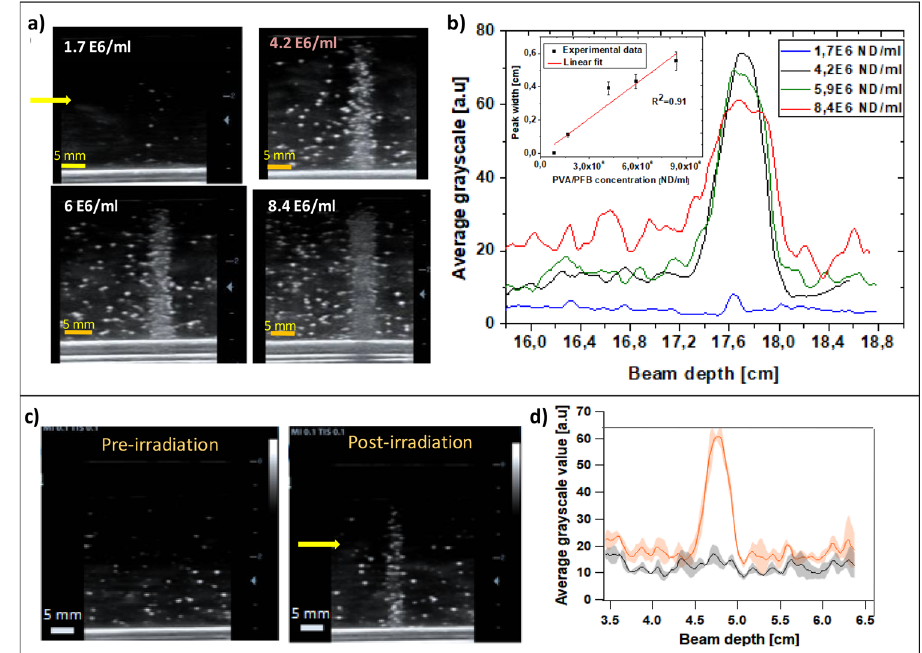
Figure 4. ( a ) US images (@7.5 MHz; MI = 0.1) of phantoms (nanodroplets concentration:1.7 × 10 6 –8.4 × 10 6 NDs/ml) post 1 Gy C-ions exposure (312 MeV/u, 180 mm); ( b ) Average grayscale value profiles of PVA/PFB NDs phantoms at the different NDs concentrations. The inset plot represents average grey value peak-width (i.e. NDs vaporization signal) as a function of NDs concentration; ( c ) US images of PVA/PFB NDs phantoms pre- and post-irradiation @ 37 °C with C-ion beam range of 50 mm (150.7 MeV/u, 1 Gy, 4 × 10 6 ND/ml); ( d ) Mean derived vaporization profiles from independent phantoms (orange) compared to the pre-irradiation grayscale signal (black). The shaded areas represent the standard deviation (n =